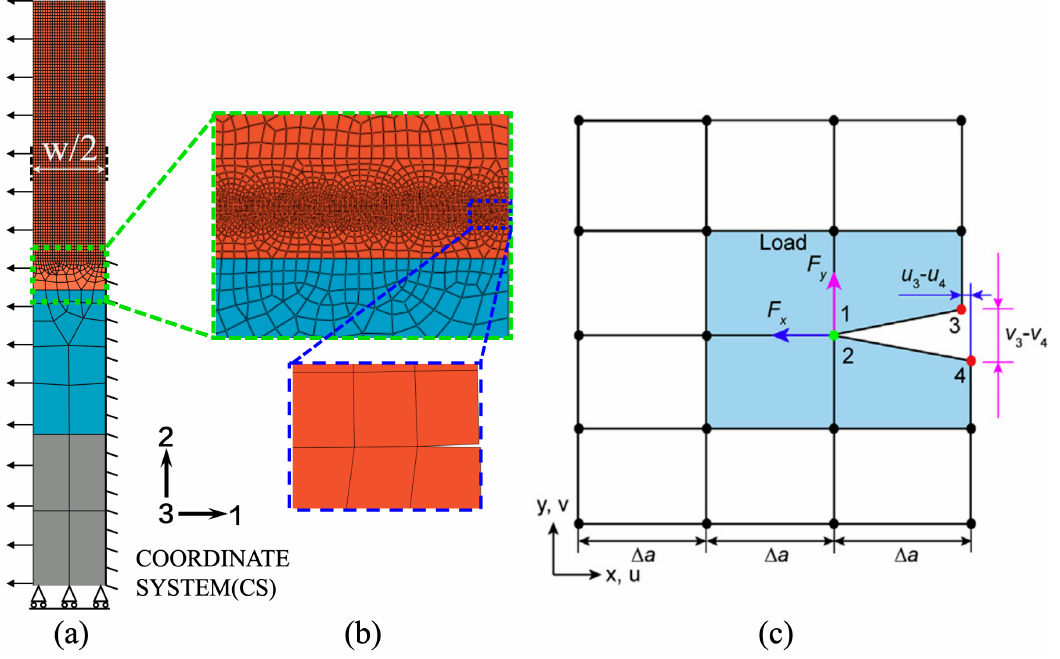
Figure 2. Model development: ( a ) finite element mesh and boundary conditions, ( b ) local cracking enlargement, ( c ) schematic of the VCCT for four node elements [49] .